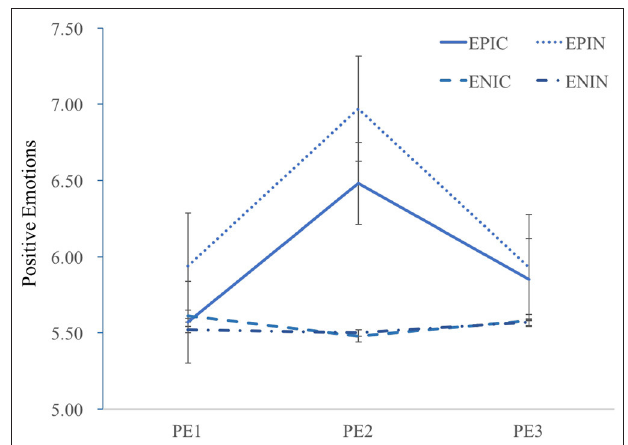
FIGURE 4 | Positive emotions (PE1, PE2, and PE3) in the formal